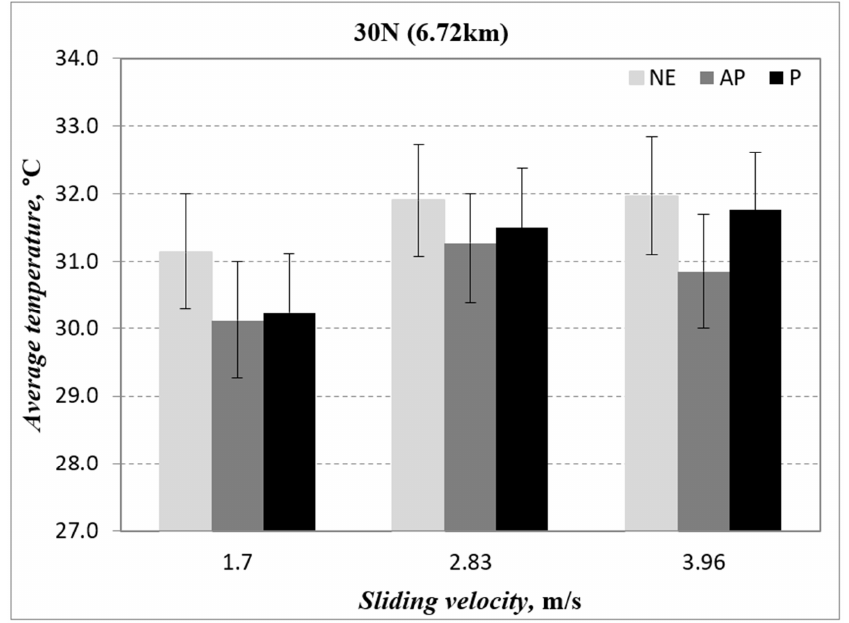
Figure 11. Temperature vs. sliding velocity for two different fibre orientations (AP and P) and neat epoxy subjected to an applied normal load of 30 N at 3.96 m/s of counterface sliding